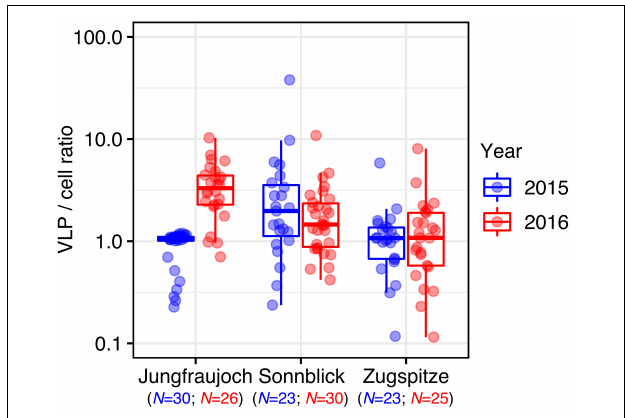
FIGURE 3 | VLP-to-prokaryotic cell ratios per site and